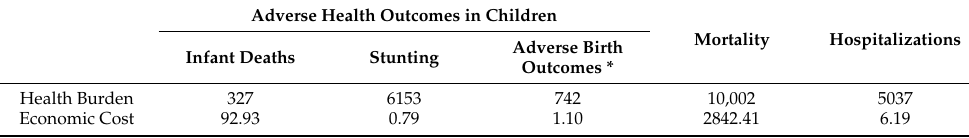
Table 7. The annual economic cost of health impact attributable to air pollution in Jakarta Province (in a million